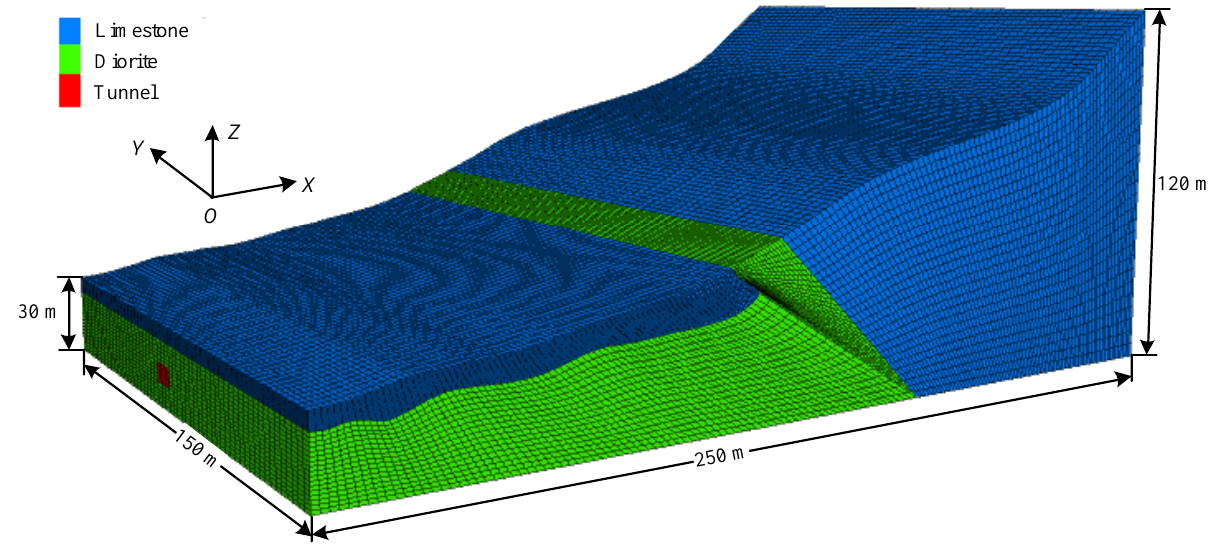
Figure 4. Grid division of tunnel.